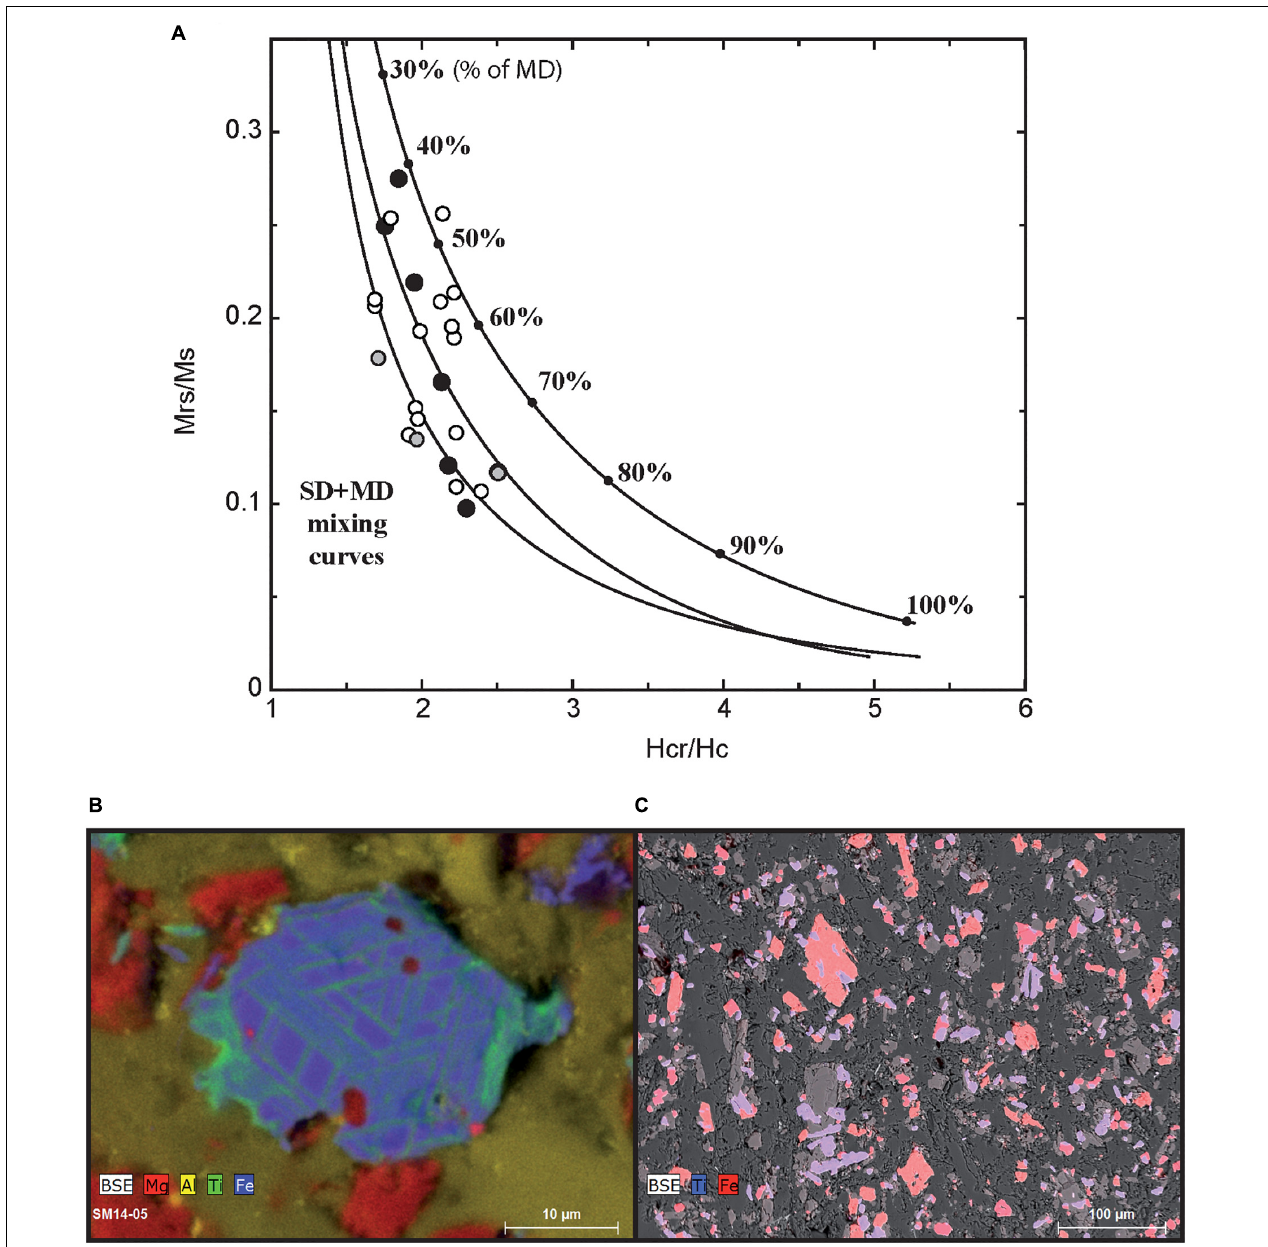
FIGURE 3 | (A) M rs /M s versus H cr /H c ratios for each flow. Theoretical mixing curves of single-domain and multi-domains grains are shown in black lines (see Dunlop, 2002a,b). Most samples lie in the 40 to 80% MD area. (B,C) SEM images of iron oxide minerals. SEM and EDS-X element mapping images of thin section for samples SM14 (B) and SM11 (C)